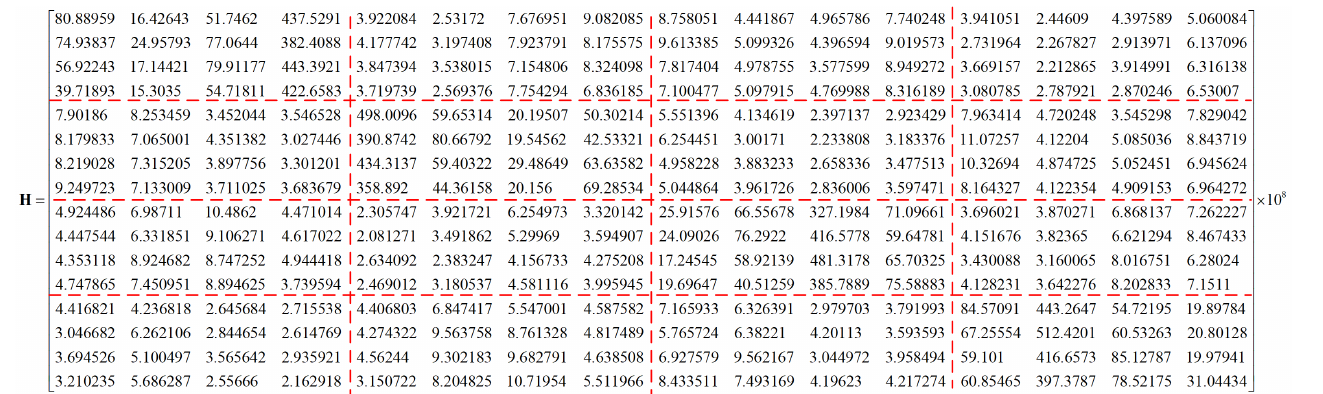
Figure 5. Channel gain matrix with transmitter and receiver